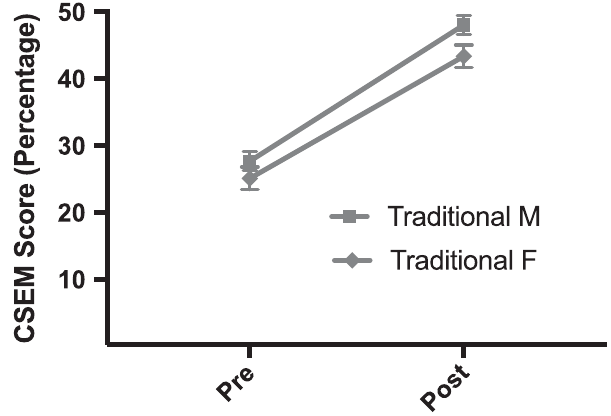
FIG. 8. Second semester (traditional instruction) average CSEM scores show a gender gap which is not initially statistically significant ( p ¼ 0 . 060 ) in presurvey scores but becomes sta- tistically significant in postsurvey scores ( p ¼ 0 . 017 ). The total number n ¼ 195 for male students ( M ) and n ¼ 58 for female students ( F ).